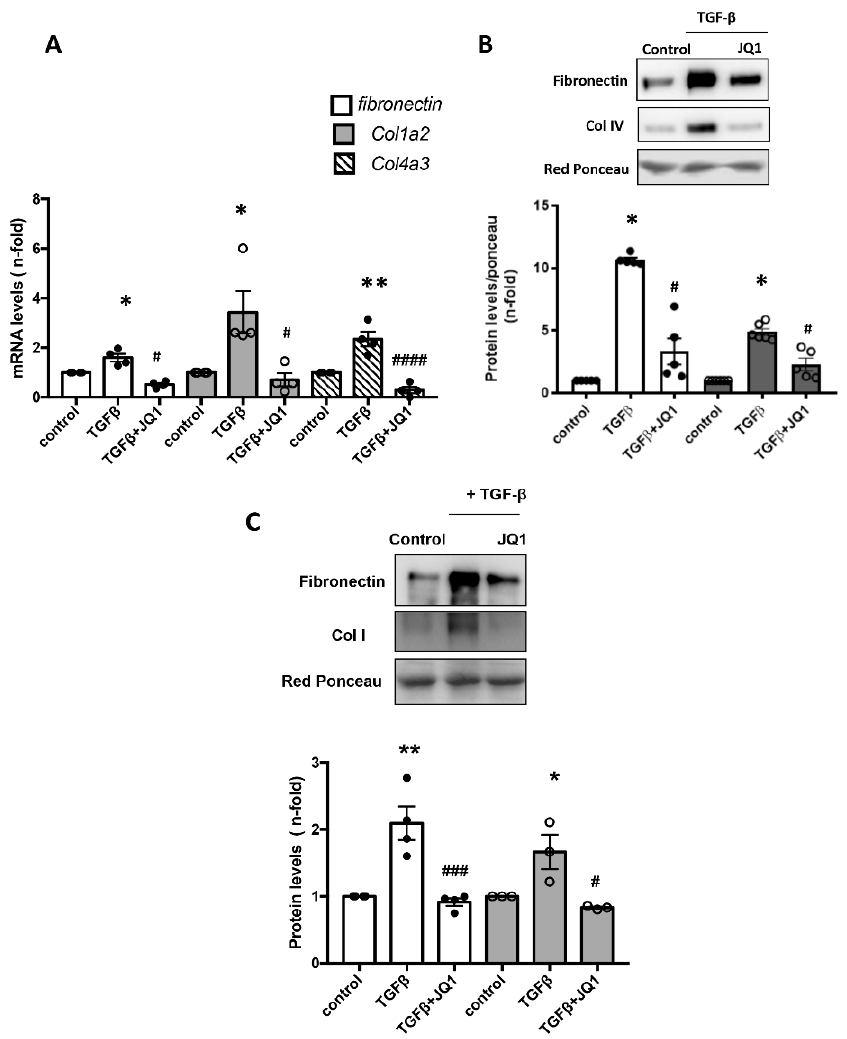
Figure 4. BET inhibition by JQ1 reduced ECM gene and protein production in human mesangial cells and murine kidney fibroblasts. Cells were pretreated with 5 uM JQ1 for 1 h and stimulated with 10 ng/mL TGF- β1 for 24 h (gene expression) or 48 h (protein expression). ( A ) Fibronectin , Col4a3 and ColIa2 gene levels were evaluated by real-time qPCR in mesangial cells. ( B ) Fibronectin and Type IV collagen (COLIV) protein levels were evaluated by Western blot in mesangial cells. ( C ) Protein levels of Fibronectin and Type I collagen (COLI) were evaluated by Western blot in kidney fibroblasts. * p < 0.05 vs. control; ** p < 0.001 vs. control; # p < 0.05 vs. treated cells with TGF- β1 ; ### p = 0.0001 vs. TGF- β1; #### p < 0.0001 vs. TGF- β1.